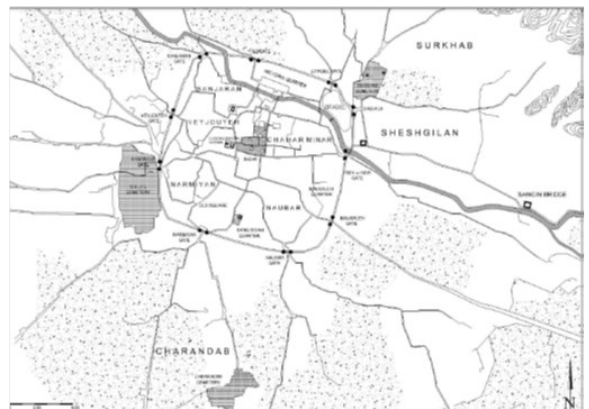
Figure 15. Remaining of Rab-e-Rashidi Complex